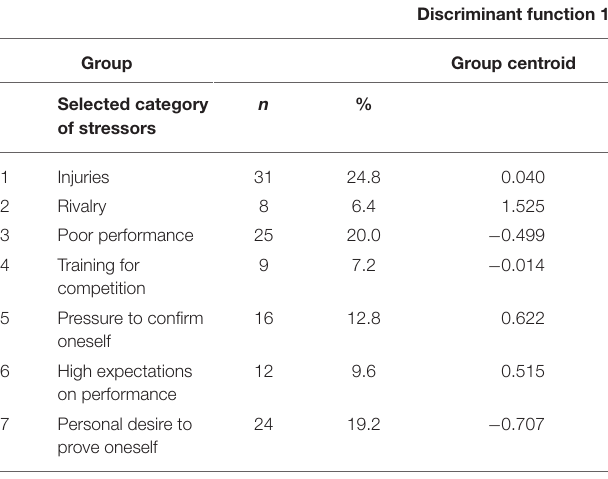
TABLE 2 | Positions of group centroids on the first canonical discriminant